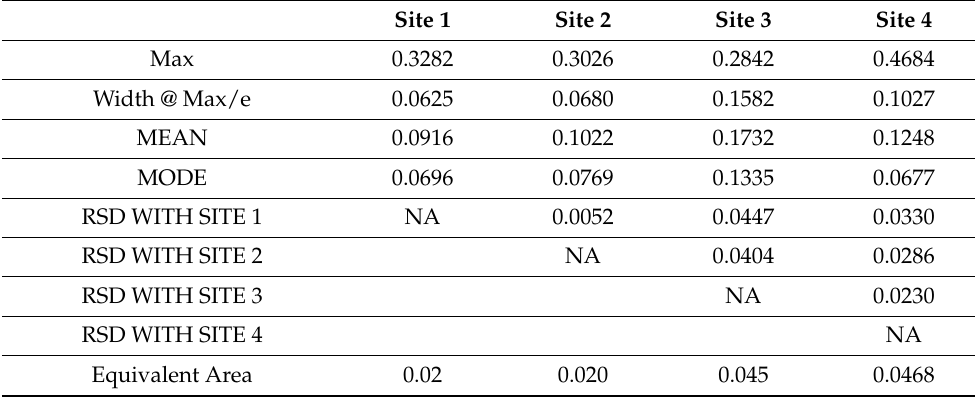
Table 4. Quality of the x-x spectrum inertia as a classifier.